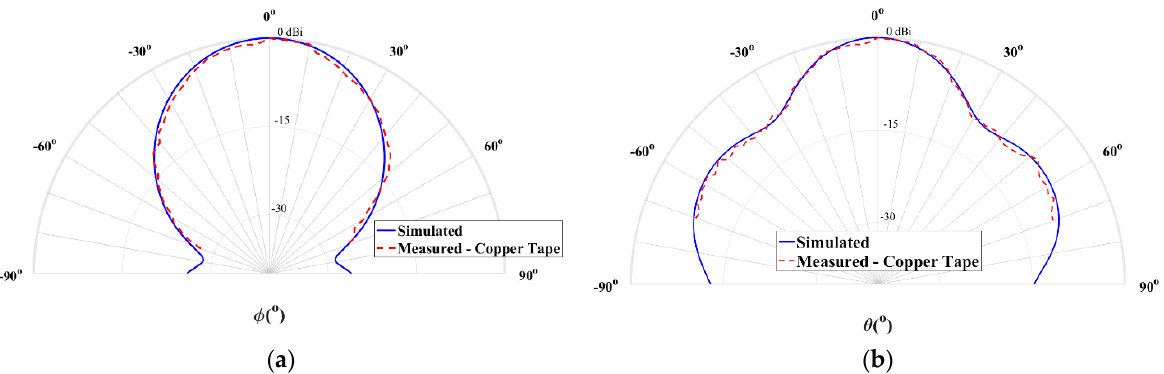
Figure 7. Simulated and measured normalized radiation pattern at 28 GHz of the horn antenna with copper tape: ( a ) plane θ = 90° and ( b ) plane ϕ = 90°.